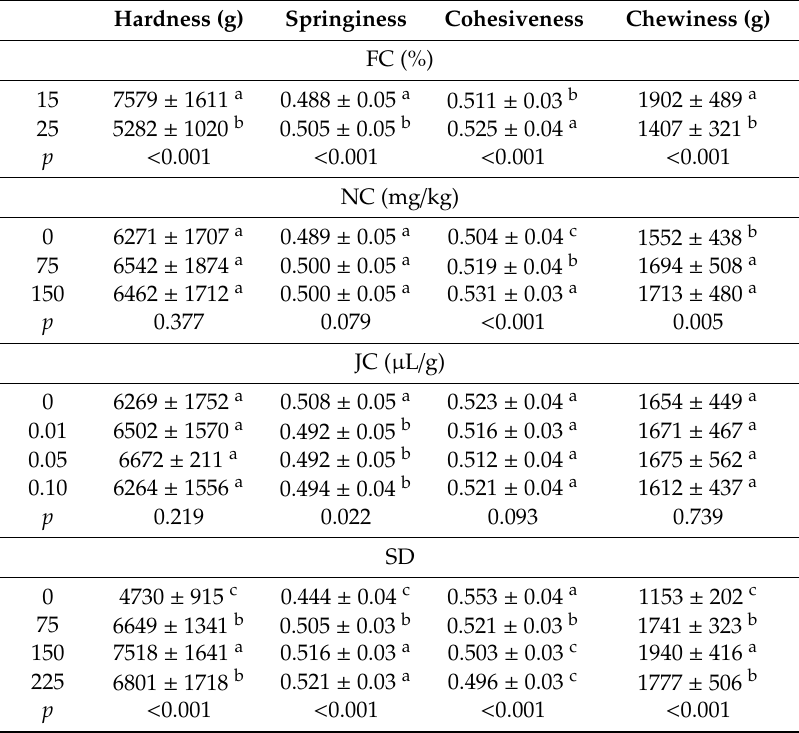
Table 4. Texture parameters of dry fermented